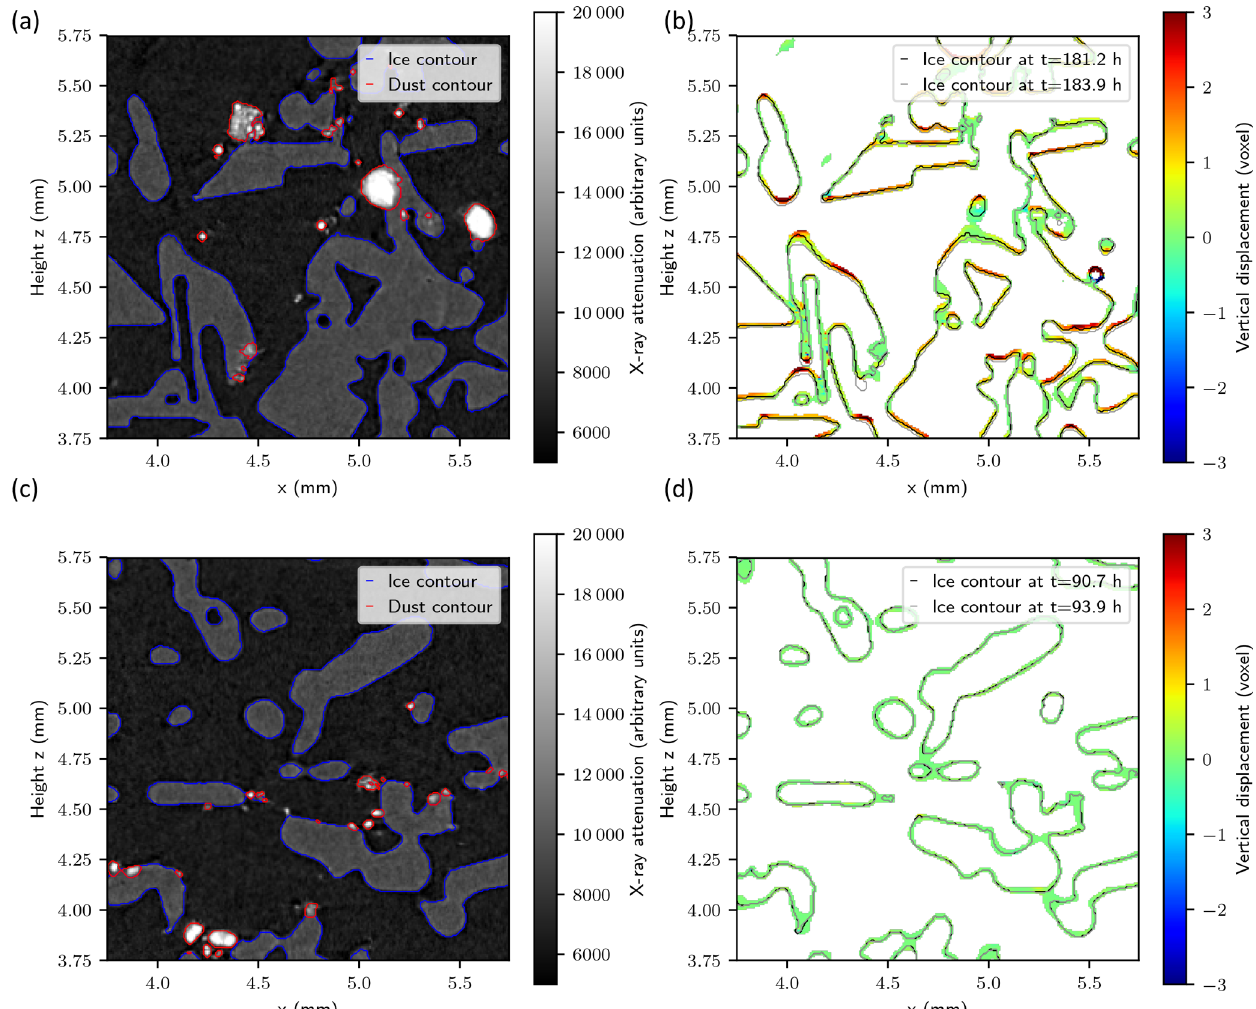
Figure A2. Example of the image processing workflow in the temperature gradient experiment (a, b) and the isothermal experiment (c, d) . Bi- nary segmentation of the grayscale X-ray attenuation image (a, c) and computation of ice interface velocity using the level set approach (b, d) . Note that for visualization purposes, the ice interface velocity is shown on a thicker interface (8 voxels width) compared to the computation used for the analysis (2 voxels). The vertical displacement between two images is shown. For example, a value of − 2 voxels means that the ice contour went down by 2 voxels (i.e., by 15µm) between the two images considered.